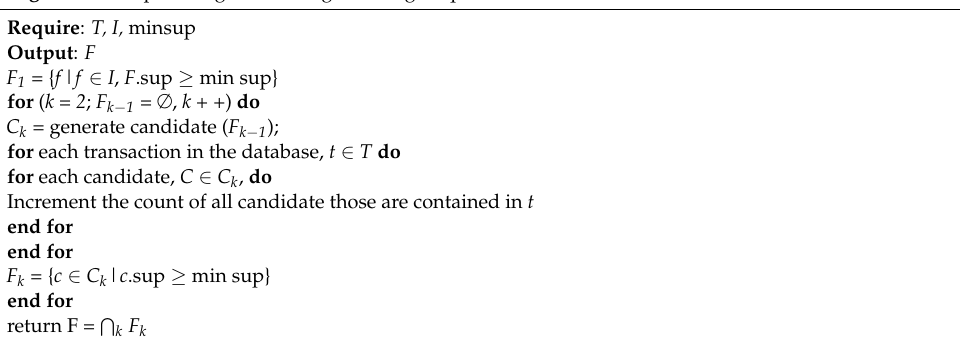
Algorithm 1. Apriori algorithm for generating frequent